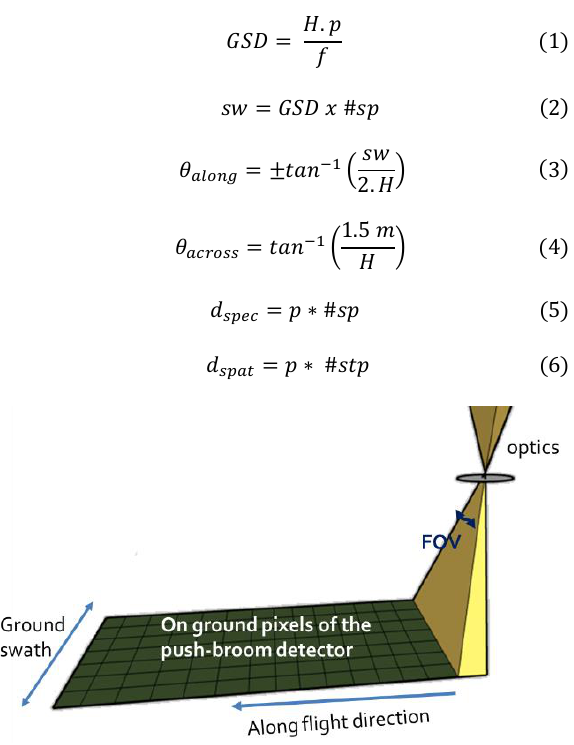
Figure 1. Scheme of the field of view (FOV) geometry and the projection of the detector array on the ground